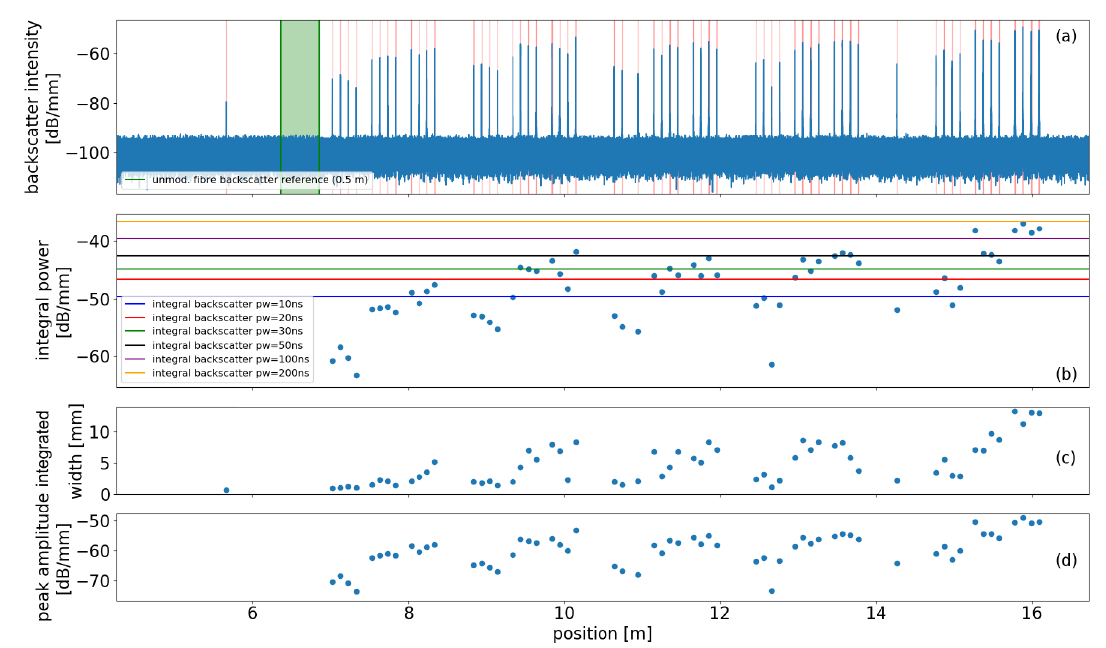
Figure 2. Properties of scattering dot specimen inscribed into the core of standard single mode optical fiber for different inscription parameters. ( a ) Distributed backscatter intensity; the green shaded (unmodified) segment is used as backscatter reference. ( b ) integral power of scattering dots; the horizontal lines depict the integral backscatter power levels of segments of unmodified standard fiber for various interrogator pulse widths W . ( c ) Integral width of peak as determined by OFDR and ( d ) peak amplitude of individual scattering